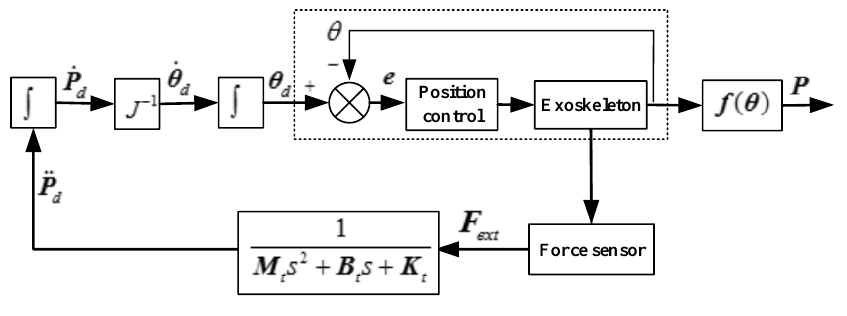
Figure 7. The active control block diagram.